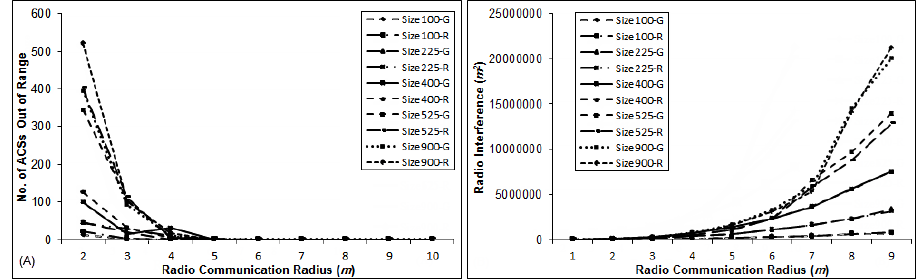
Figure 5. No. of ACSs out of range (A), and radio interference (B) versus radio communication radius.